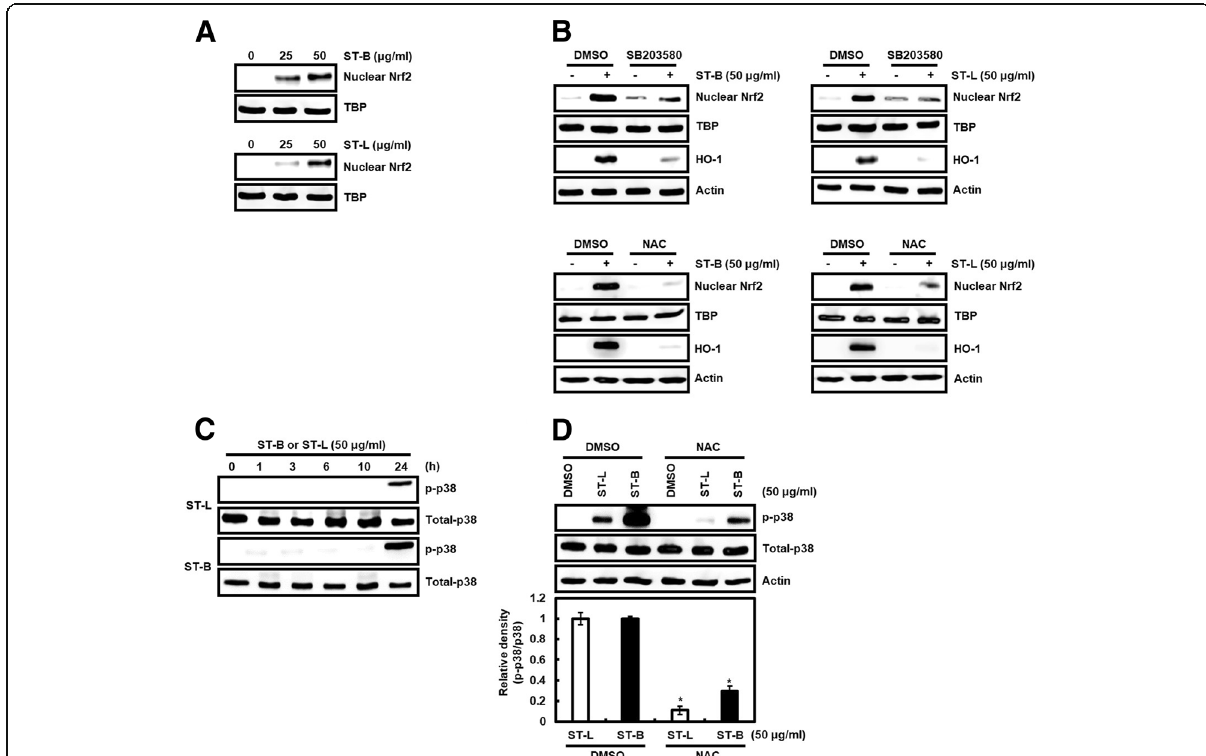
Fig. 6 HO-1 expression by STL and STB is through Nrf2 activation dependent on ROS-mediated p38 activation. a SW480 cells were treated with STL and STB for 24 h. b SW480 cells were pretreated with SB203580 (20 μ M) or NAC (20 mM) for 2 h, and then co-treated with STL and STB for the additional 24 h. c SW480 cells were treated with STL and STB for the indicated times. d SW480 cells were treated with NAC (20 mM) for 2 h, and then co-treated with STL and STB for the additional 24 h. Actin, TBP or total-p38 was used as loading control. * P < 0.05 compared to the cells without STL and